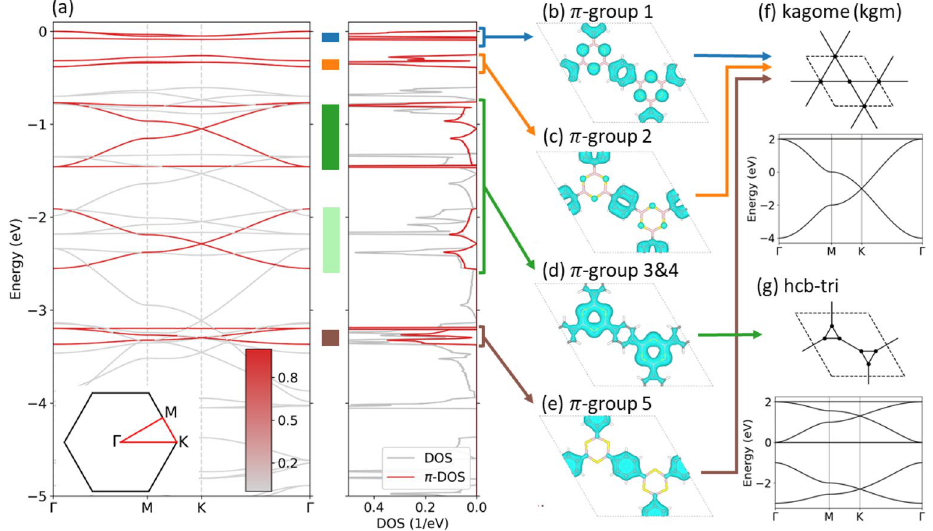
Figure 5. ( a ) Band structure of COF-BS-1Ph, projected on all π -orbitals, and density of states (DOS) for all states and π -states ( π -DOS). Zero energy is put to the top of the valence bands. Colored stripes indicate the bandwidth for every group of π -bands. The Brillouin zone is shown as inset. ( b – e ) Partial charge densities at the Ŵ -point from the indicated group of π